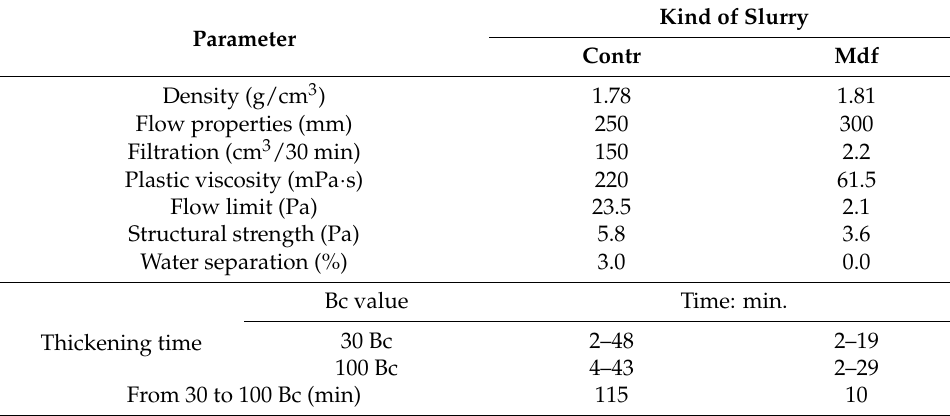
Table 2. Technological parameters of the fresh